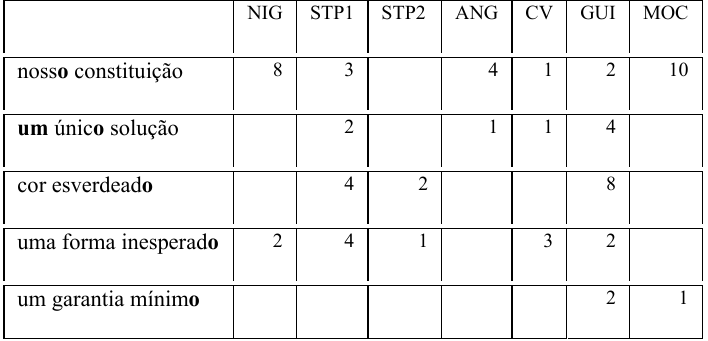
Table 8: Patterns of defective gender agreement in all